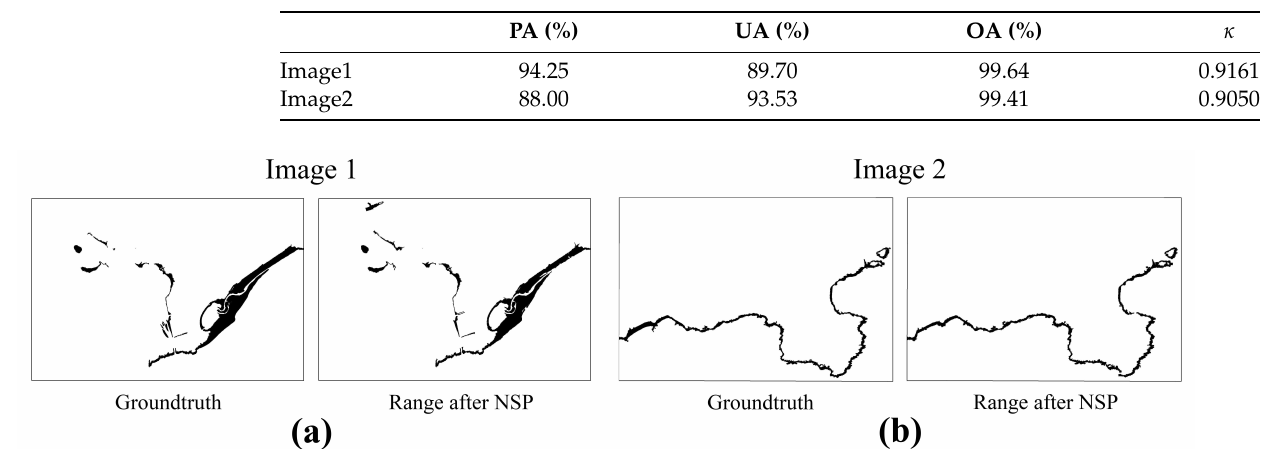
Figure 12. Results after NSP from two images in 2015. ( a ) Groundtruth and result of Image 1. ( b ) Groundtruth and result of Image